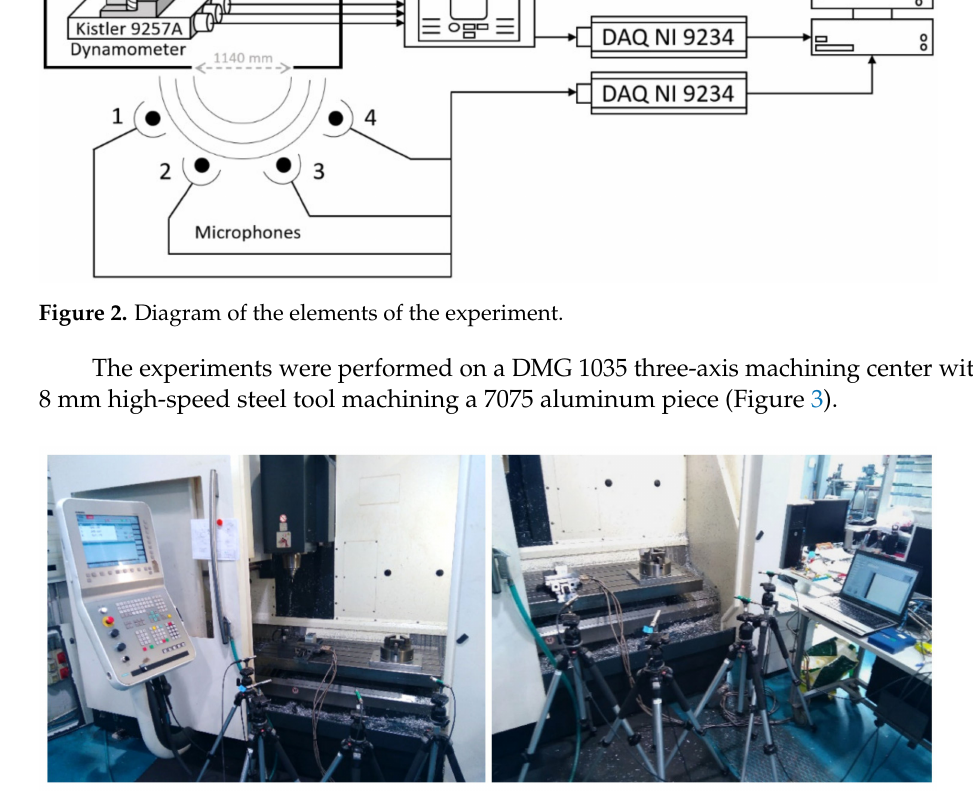
Figure 3. Pictures of the experimental